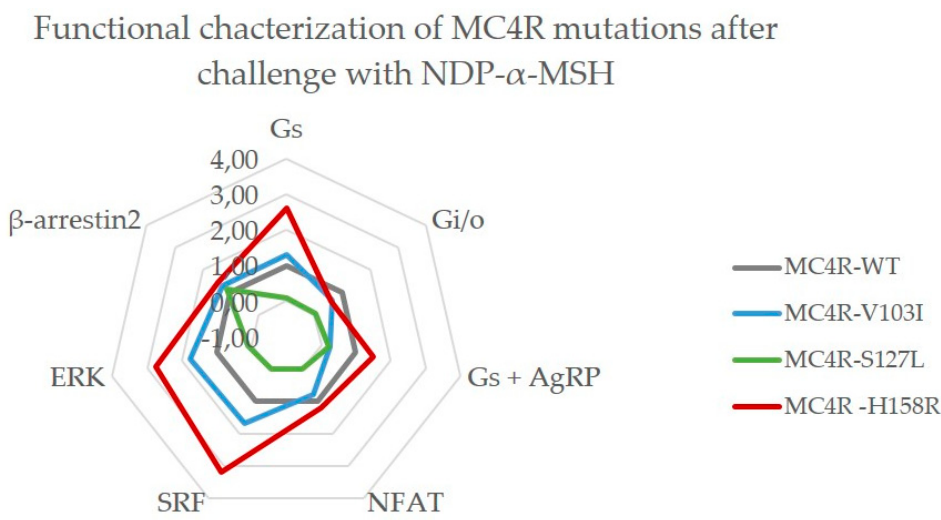
Figure 6. MC4R V103I and H158R lost their bias towards G q / 11 after NDP- α -MSH stimulation. As a reference, MC4R WT (gray) is plotted at a value of 1.0. The MC4R V103I mutant (blue) lost the increased G q / 11 signaling (NFAT) but gained a moderate bias towards G 12 / 13 (SRF) and ERK phosphorylation. The loss-of-function mutation S127L (green) could not be rescued by NDP- α -MSH in most pathways, but β -arrestin2 recruitment was restored to WT-like. The H158R mutant (red) kept its gain-of-function in G S signaling as was well as in G 12 / 13 and ERK phosphorylation, at the same time it lost the strong bias towards G q / 11 that was displayed with the α -MSH challenge. Each value is based on EC 50 and E max values that were derived from non-linear regression models fitted to the concentration–response curves for each pathway from three to seven independent experiments performed in triplicates.